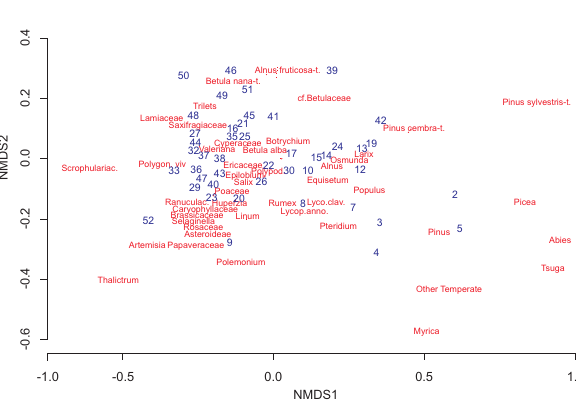
Figure 5. Ordination of revealed pollen spectra. The two- dimensional nMDS plot mirrors the similarity among the different pollen zones (i.e., its position represents the centroids of the respec- tive pollen samples) and the major characteristics of their pollen assemblages. A few less important taxa were deleted for clarity.